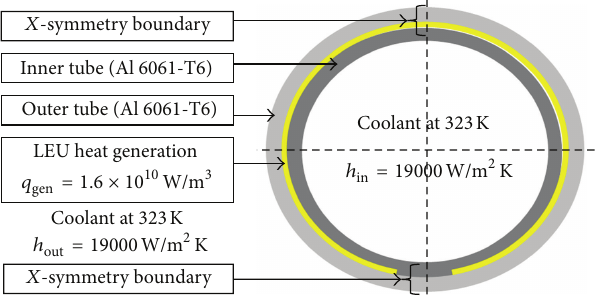
Figure 7: Loading and boundary conditions for the irradiation model in the third analysis